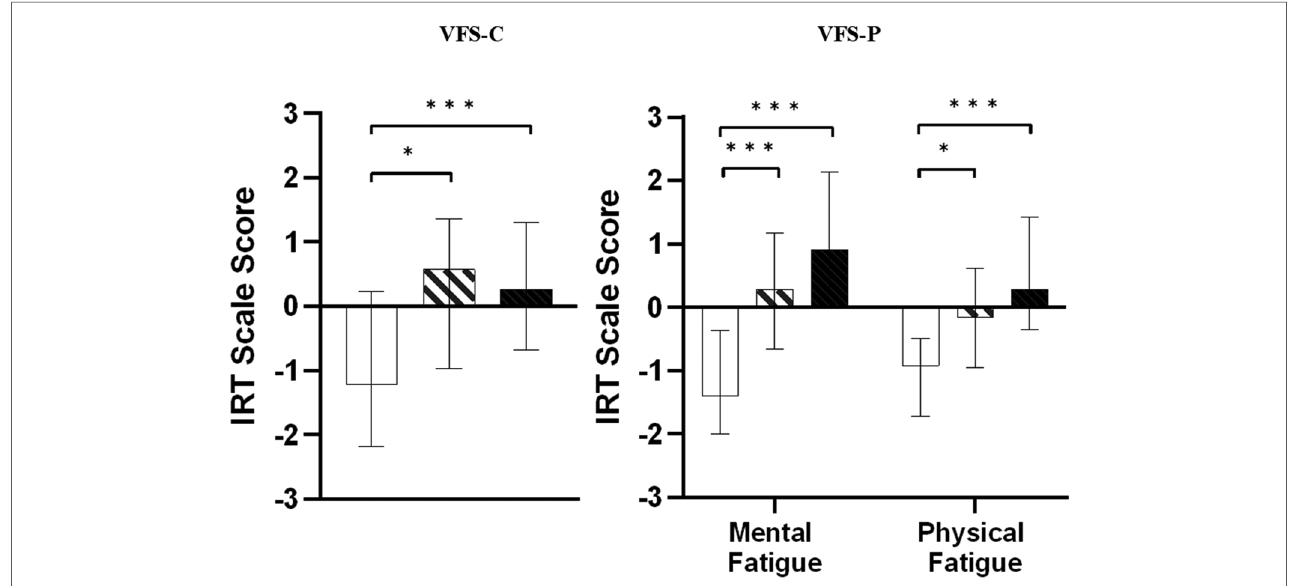
FIGURE 3 Median item response theory (IRT) scale scores for the VFS-children (left) and VFS-parent (right). Greater values indicate a greater level of fatigue. Bars and error bars shown represent medians±IQRs. CNH; white bars, CUHL; oblique stripes, CBHL; black bars respectively. Asterisks show signi fi cant differences between groups (* p <0.05, ** p <0.01, *** p <0.001).